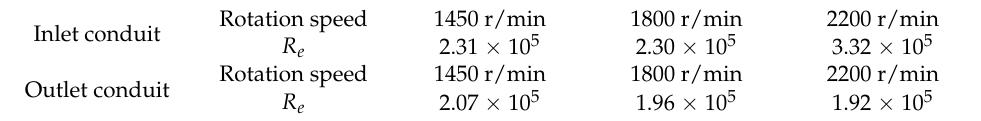
Table 2. Reynolds number of the flow in the inlet and outlet conduits at different rotation speeds. Inlet